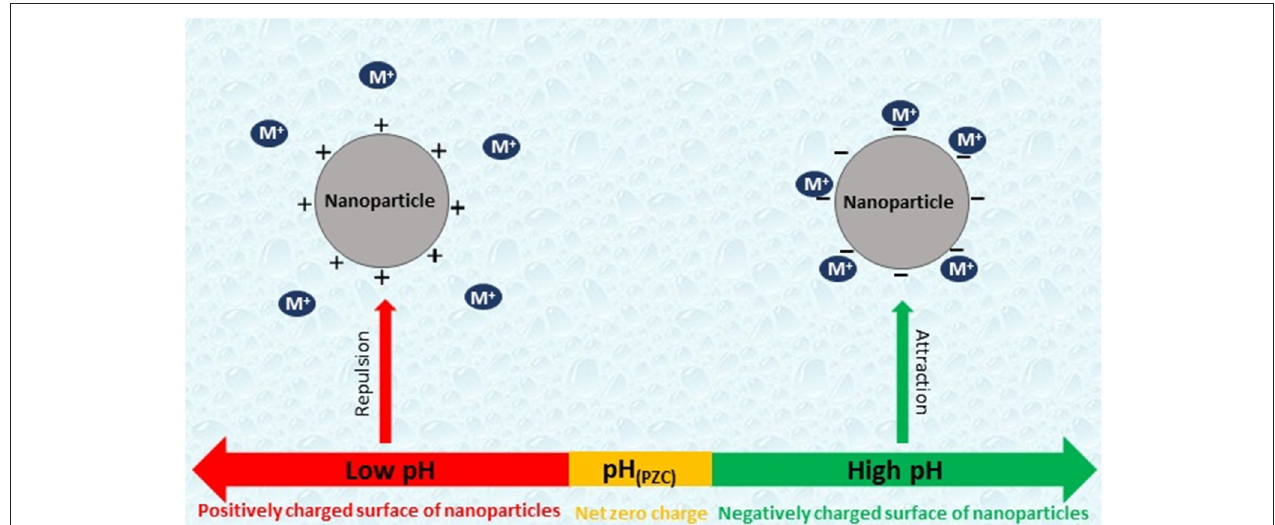
FIGURE 2 | The interaction between positively- and negatively-charged surface of a nanoparticle and positively charged metal ions (M + ) in a solution at pH values below and above the point of zero charge